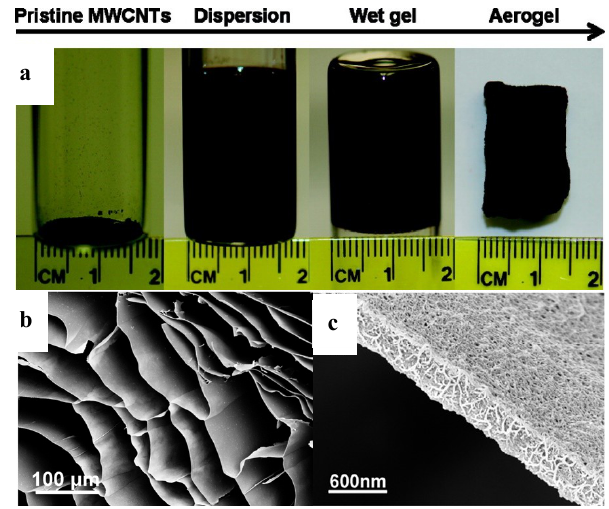
Figure 4. ( a ) Fabrication of CNT aerogels using (P3HT-b-PTMSPMA), ( b ) scanning electron microscopy (SEM) image of the macroporous honeycomb structure of the aerogel with ~100-nm-thick walls, and ( c ) SEM image of the aerogel walls with entangled CNTs. Reprinted from [56] with permission, copyright American Chemical Society,